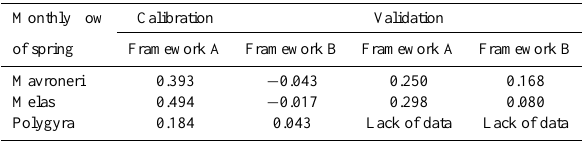
Table 3. Bias in mean monthly flow (observed minus com- puted) in m 3 s − 1 for the period of calibration (October 1984– September 1990) and validation (October 1990–September